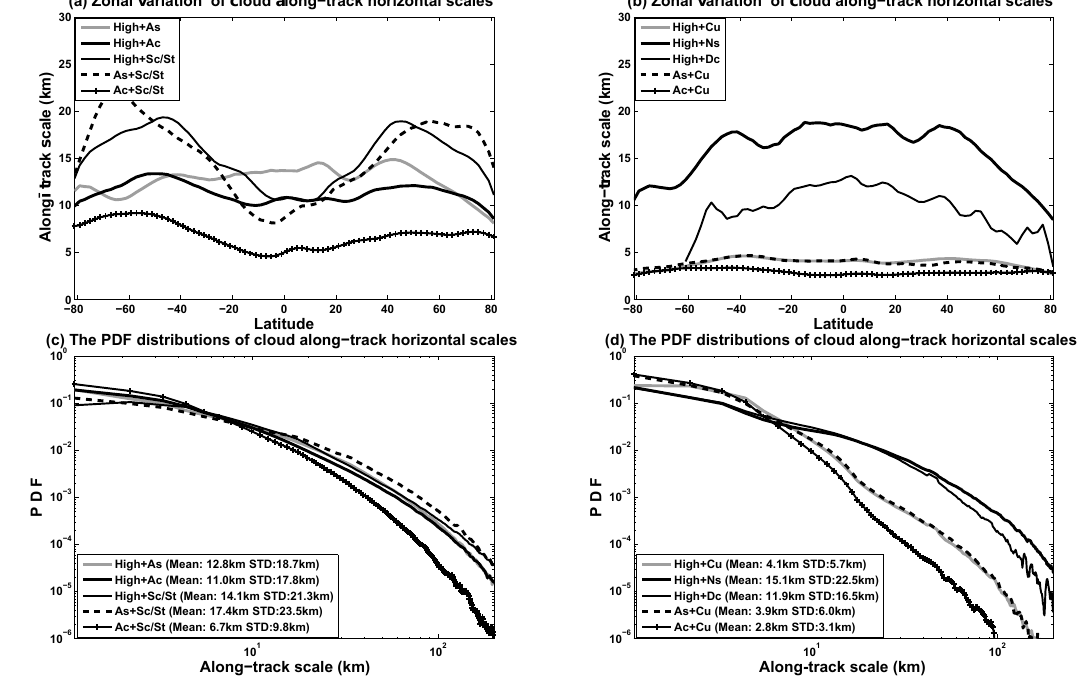
Figure 4. (a, b) The zonal variation of cloud along-track horizontal scales for these multilayered cloud systems and (c, d) their probability